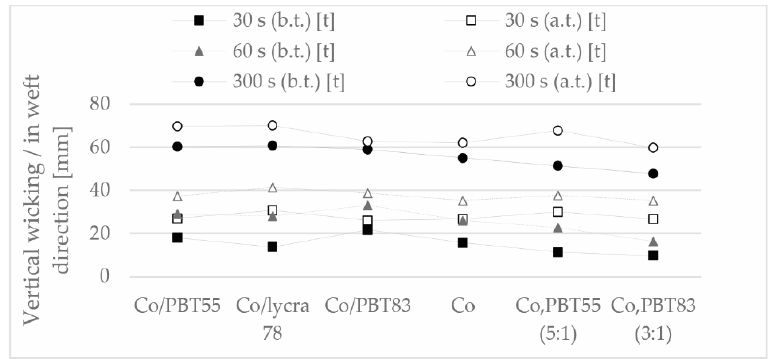
Figure 9. Moisture management (vertical wicking) of the samples in warp direction (measures distance in mm at a certain time), before (b.t.) and after (a.t.) thermal treatment.